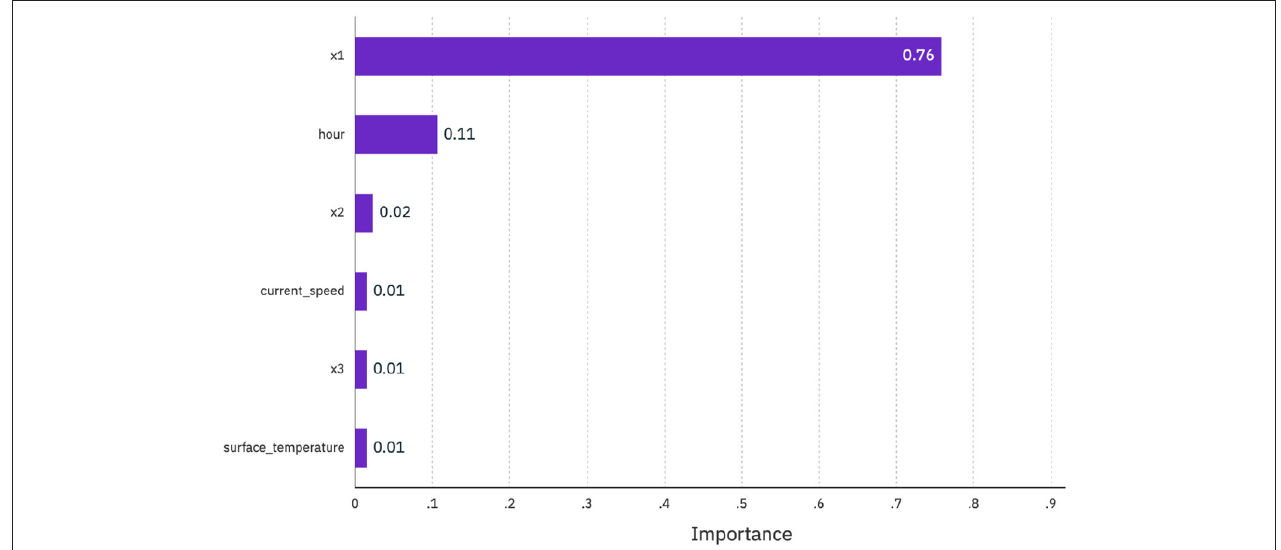
FIGURE 7 | Feature importance reported for first experimental configuration “all features” (section 2.3) at the CAN site. We provided all available data as features to the model (i.e., environmental data, temporal data, and autoregressive data or fish position at previous 3 h). The y -axis reports ranked list of features that contributed the most to variation in fish depth measurements, while the x -axis presents relative magnitude of those contributions. Ranking predictors in this manner can quickly help sift through large datasets and understand data trends (Kuhn and Johnson, 2013).